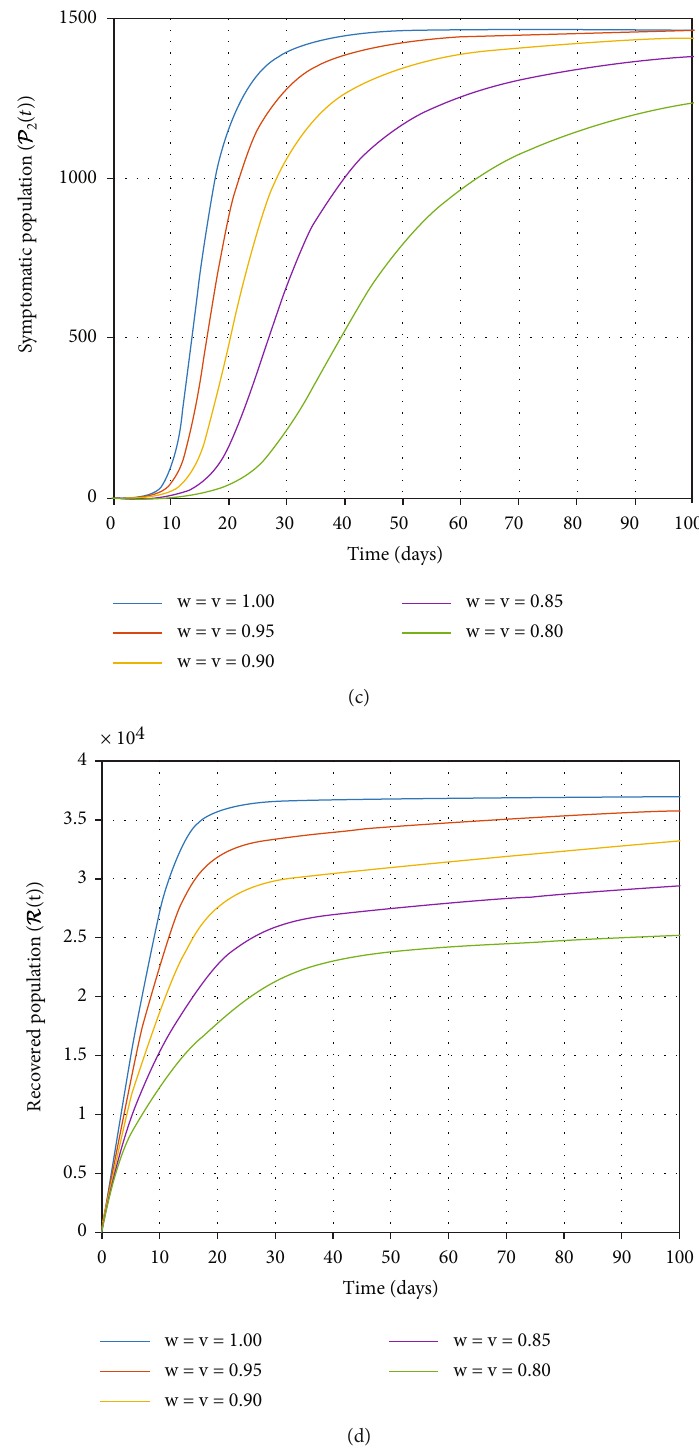
Figure 2: Behaviors of each compartments: (a) S ð t Þ , (b) P 1,0 : 95,0 : 90,0 : 85,0 : 80 with the estimated parameters from the reported